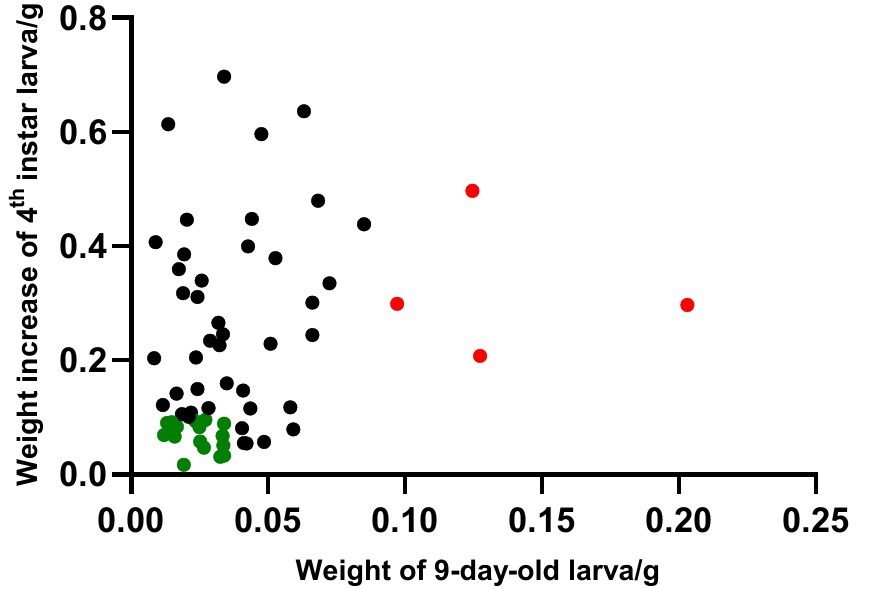
Figure 3. Scatter plot of weight increase of 4th instar larva after feeding on leaves for 72 h and weight of 9-day-old larva. The red dots in the figure represent the sensitive varieties, and the green dots represent the resistant varieties. Table 1. Insect-sensitive or resistant yardlong bean varieties screened by evaluation of newly hatched larvae and 4th instar larvae weight increase.